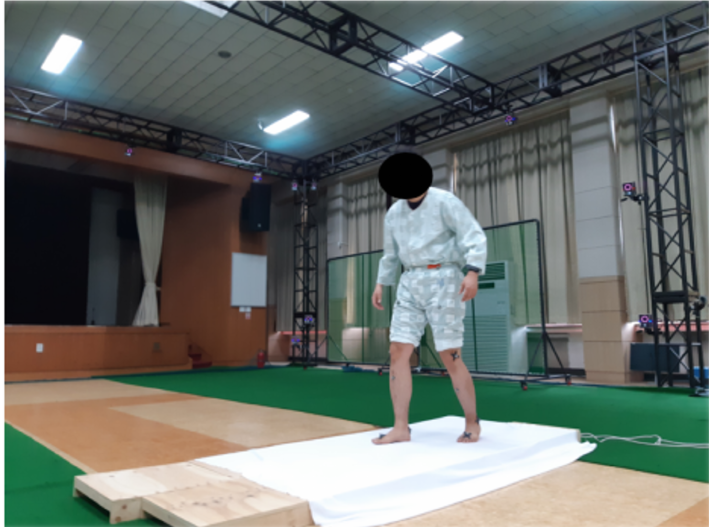
Figure 1. An overview of the experimental environment: Participants walk on the force plate, which can measure three directional ground reaction forces (GRFs) and moments. Because of the limitation of force plate hardware specification, the force plate allows us to measure only one-step gait in this